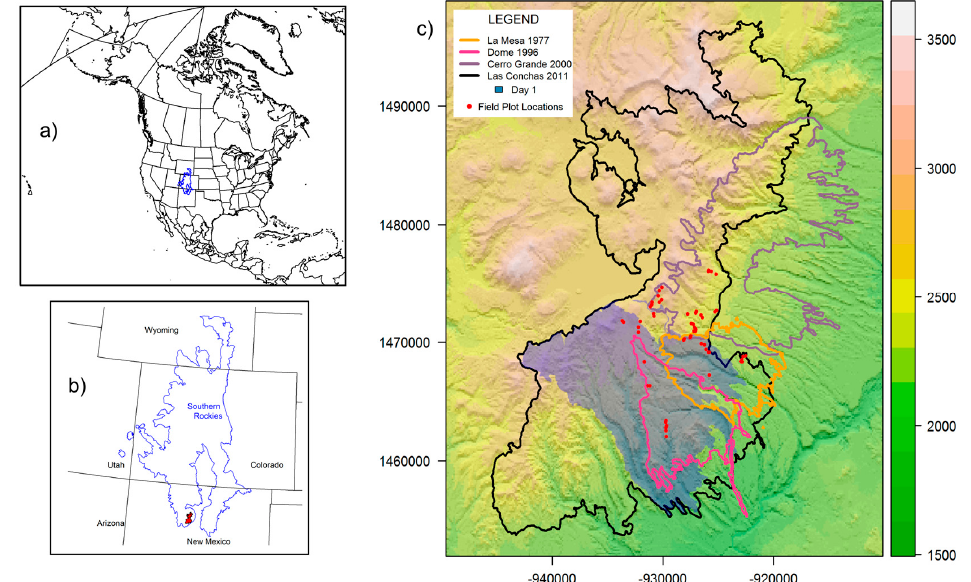
Figure 1. The study area is located at the southern end of the Southern Rockies Ecoregion, North America in northern New Mexico, USA, where several large fires have occurred in recent decades. The Southern Rockies Ecoregion is shown in blue outline in the locator map of North America ( a ) and in the locator map of the southwestern states ( b ). The study area is shown in red in map ( b ). The perimeters of recent fires included in the study are shown with a background of elevation gradient (m) overlaid with hillshades ( c ). The Las Conchas fire (2011) reburned portions of several previous fires including: La Mesa (1977), Dome (1996) and Cerro Grande (2000). Progress of Las Conchas was rapid in the first day of burning ( c ; area shaded gray). We used field plot data from Coop et al. (2016; c ; red dots). Projection is the Albers Equal Area (units = m).